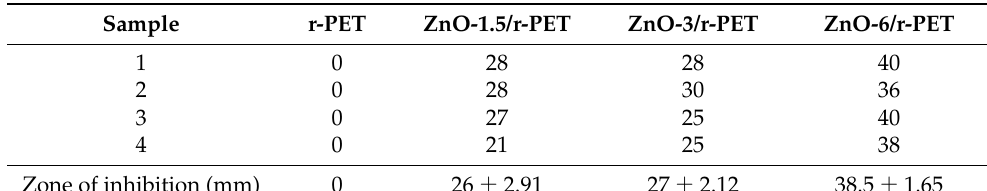
Table 3. Average diameters in millimeters of the inhibition haloes of Bacillus subtilis bacteria at different concentrations of ZnO-NPs. Table 4. Average diameters in millimeters of the inhibition haloes of Escherichia coli bacteria at different concentrations of ZnO-NPs.